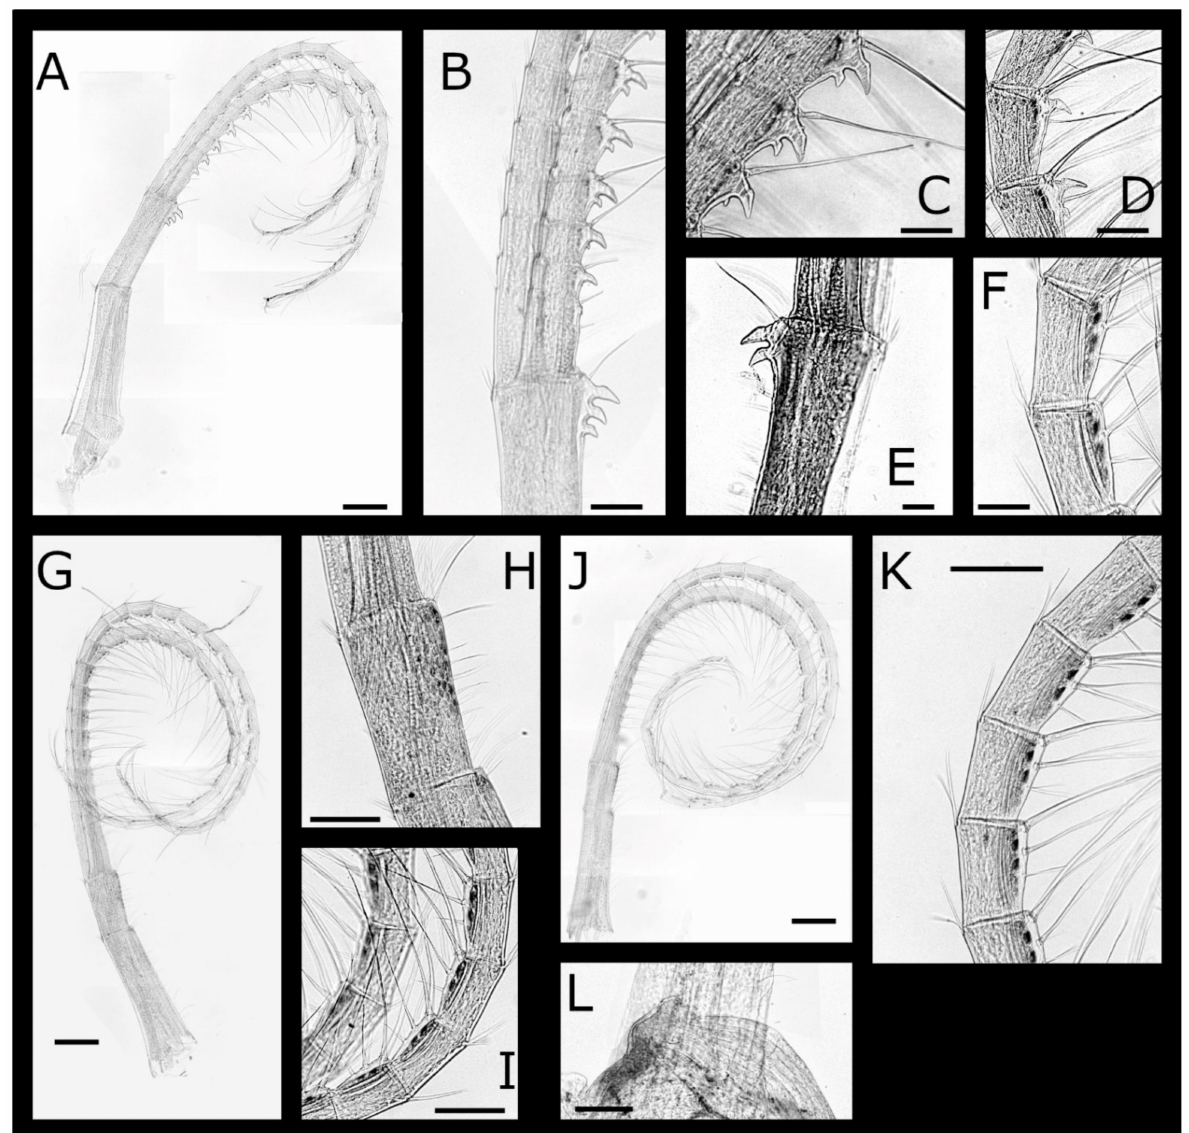
Figure 12. Euacasta acutaflava sp. nov. cirri IV–VI of holotype (WAM C58744) ( A ) left cirrus IV; ( B ) basal segments of rami and basis of left cirrus IV protopod; ( C , D ) medial segments of left cirrus IV anterior ramus; ( E ) teeth on basis of right cirrus IV protopod; ( F ), medial segments of left cirrus IV posterior ramus; ( G ) left cirrus V; ( H ) basis of left cirrus V protopod; ( I ) medial segments of right cirrus V; ( J ) left cirrus VI; ( K ) medial segments of left cirrus VI; ( L ) basidorsal point of penis. Scale bars: A, G, J =200 µ m; B, H–I, K–L 100 µ m; C–E = 50 µ m. Euacasta excoriatrix sp. nov. (Figures